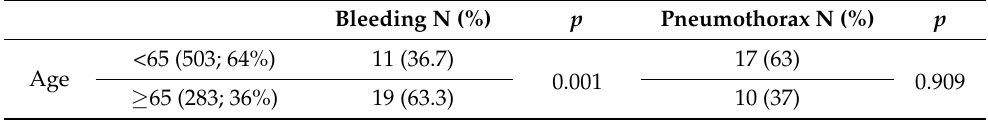
Table 2. Patients ’ age and complications rate.